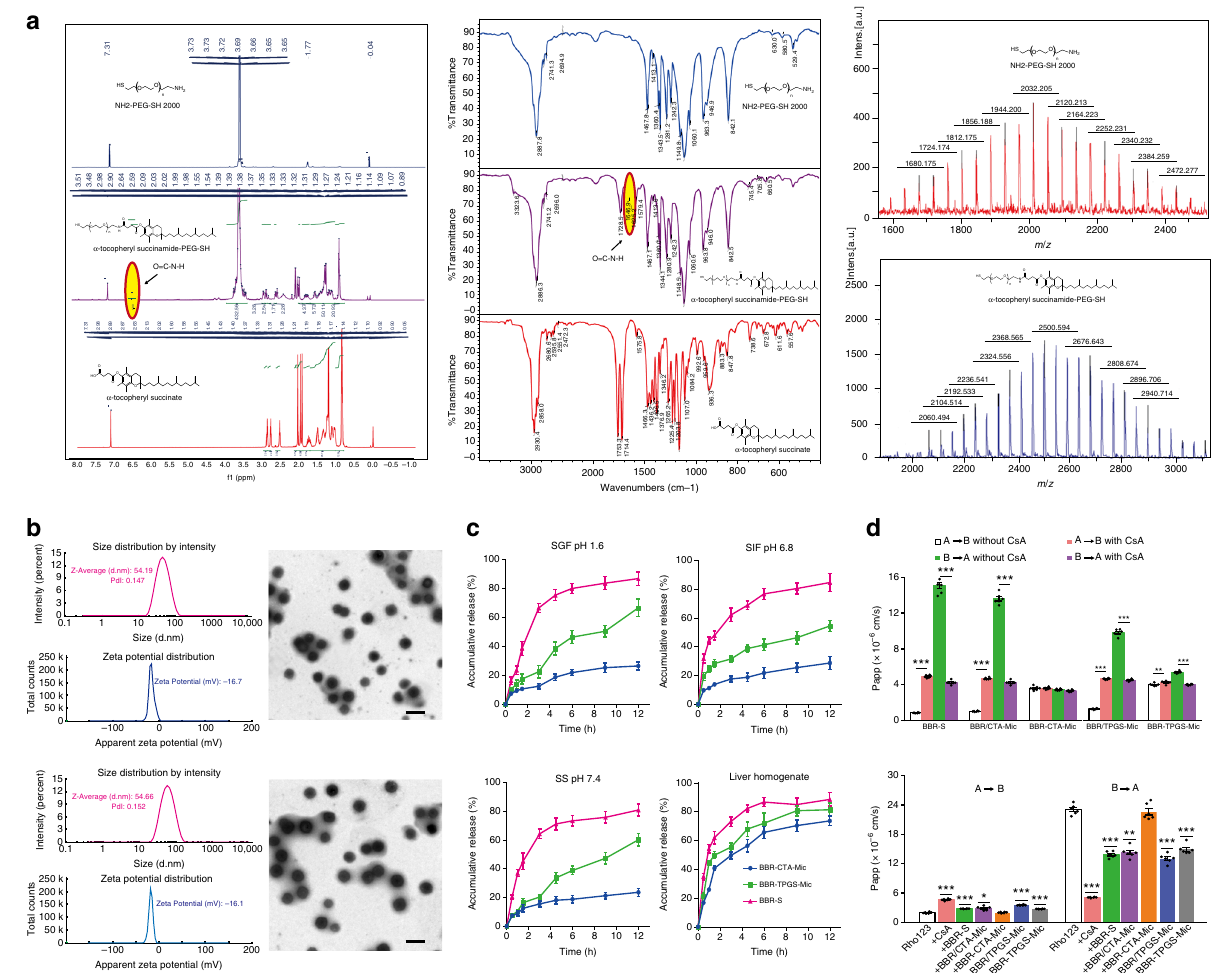
Fig. 1 Characterization of TPGTSA and BBR-CTA-Mic. a The physical properties of TPGTSA. Left: Nuclear magnetic resonance hydrogen spectrum ( 1 H- NMR); middle: Flourier transformation infrared spectroscopy (FTIR); right: matrix-assisted laser desorption/ionization time of mass spectrometry (MALDI- TOF-MS). b Particle size, Zeta potential and morphology of empty CTA-Mics (up) and BBR-CTA-Mics (down). c Drug release study. The release of BBR from BBR-CTA-Mic and BBR-TPGS-Mic was carried out by dialysis method. BBR-S was used as control. 0.4 mL of BBR-S or BBR containing Mics was sealed in dialysis bags and submerged in 50 mL of fasting state simulated gastric fl uid (SGF, pH 1.6), fasting state simulated intestinal fl uid (SIF, 5 mM of bile salts, pH 6.8), simulated serum (SS, 20% FBS albumin, pH 7.4) and simulated liver environment (20% mice liver homogenate), respectively. Data are presented as mean ± SEM ( n = 5). d Trans-epithelial transport study of BBR formulations in Caco-2 cell lines. Up: bidirectional apparent trans-epithelial permeability (Papp) of BBR contained formulations and the effect of CsA on the transport of different samples; down: the effect of different BBR containing formulations on Rho123 transportation. Data are presented as mean ± SEM ( n = 6), * p < 0.05, ** p < 0.01, *** p < 0.001, vs untreated control, p- values were calculated by unpaired two-sided Student ’ s t -test. Scale bars, 100 nm ( b